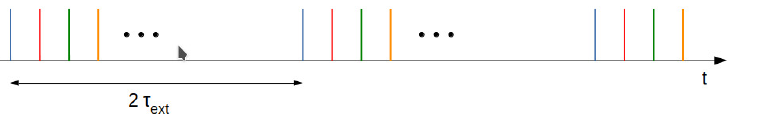
Figure 9. Illustration of the multiple repetitions of pulses in an external cavity roundtrip time 2 τ ext : the colors indicate independent pulse